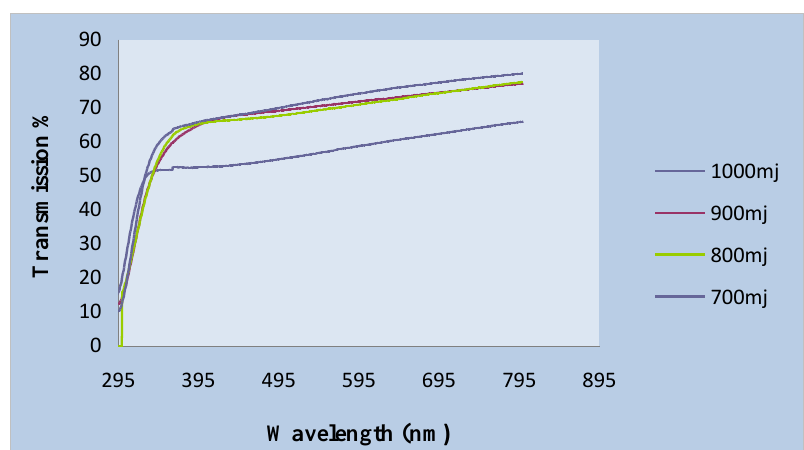
Fig.2: Optical transmission as a function of wavelength for ZnS/glass at different laser energy.